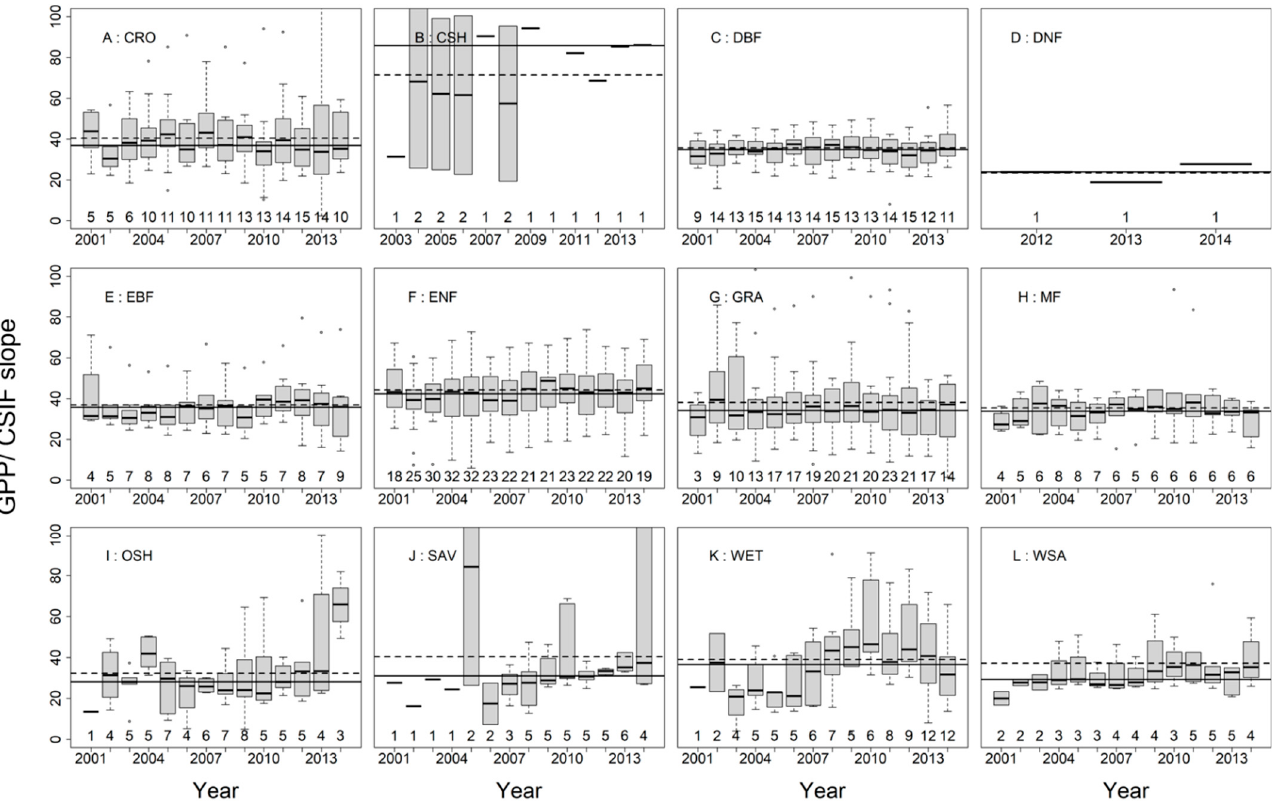
Figure 4. Interannual variability of the slopes between CSIF and GPP across 12 biomes are similar to those in Figure 1. The explanation of the boxplot symbols is given in Figure 3. The solid line and dash line across each boxplot are the median value and mean value for the whole boxplot (biome), respectively. The number of flux tower sites for each year is shown on top of the x axis.